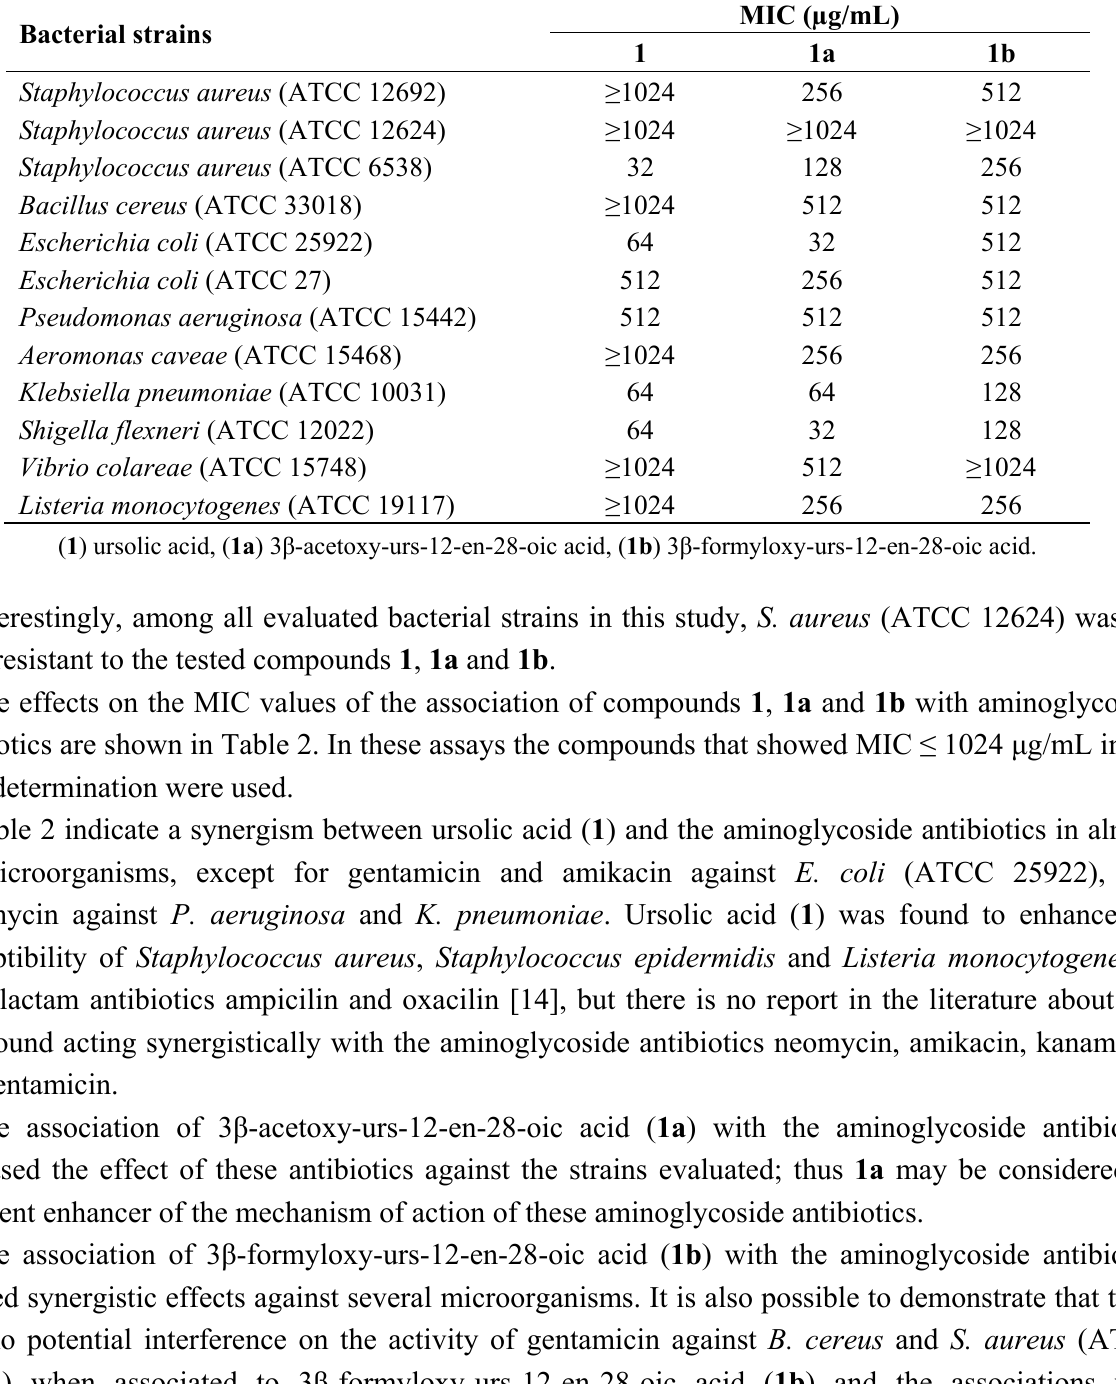
Table 1. Values of the minimal inhibitory concentration (MIC) of compounds 1 , 1a and 1b . Bacterial strains Staphylococcus aureus (ATCC 12692) ≥ 1024 Staphylococcus aureus (ATCC 12624) Staphylococcus aureus (ATCC 6538) 32 Bacillus cereus (ATCC